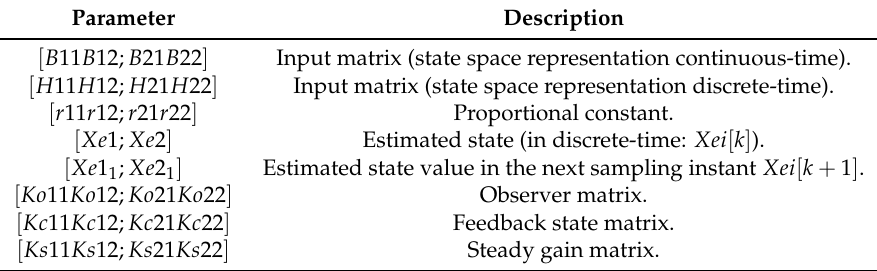
Table A12. Parameters and variables of observer and state feedback control. Parameter